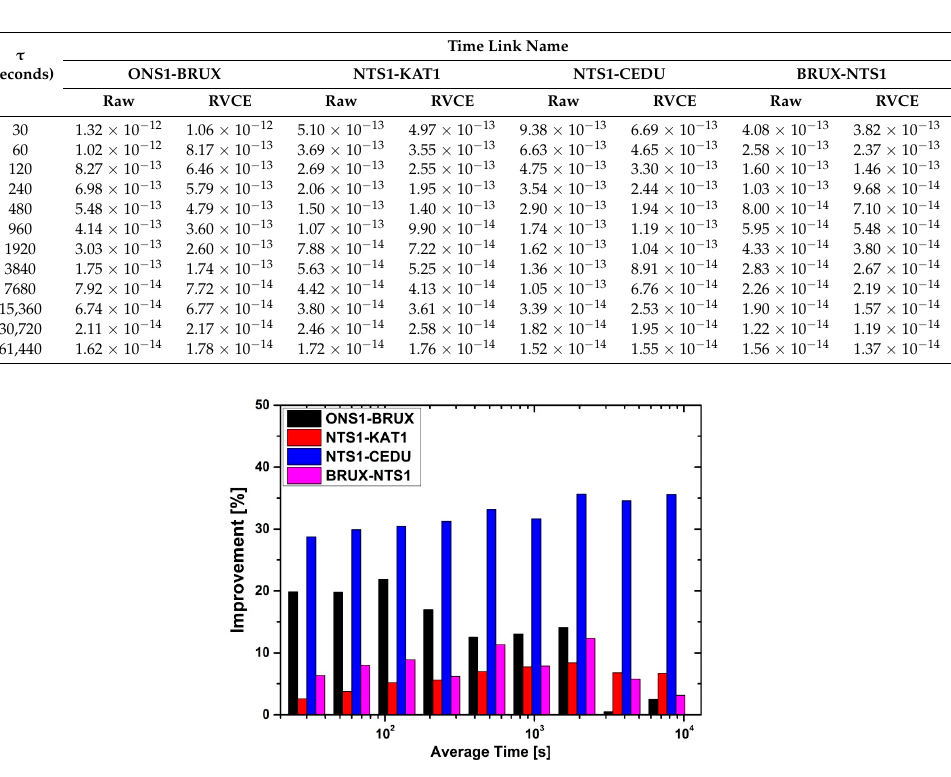
Figure 6. Comparison of Allan deviation (ADEV) for the four time links determined with and without RVCE. ( a ) is for ONS1-BRUX, ( b ) is for NTS1-KAT1, ( c ) is for NTS1-CEDU and ( d ) is for BRUX-NTS1. Table 5. ADEV values of the four time links determined with and without RVCE.